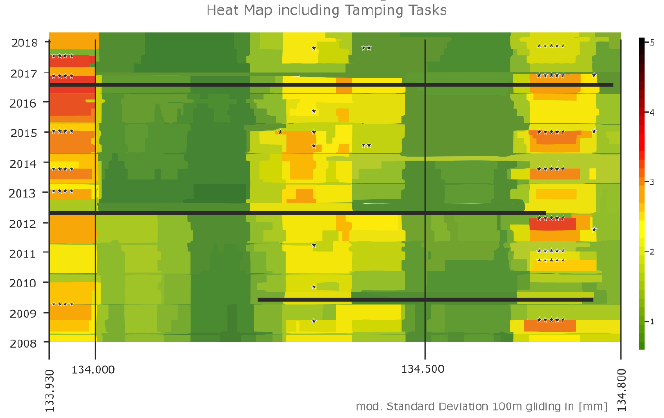
Figure 3. Heat Map of SDLL (gliding 100 m) over Time including Tamping Tasks depicting Loss of Track Quality (from green to red) and especially Single Failures with fast Geometry Deterioration.